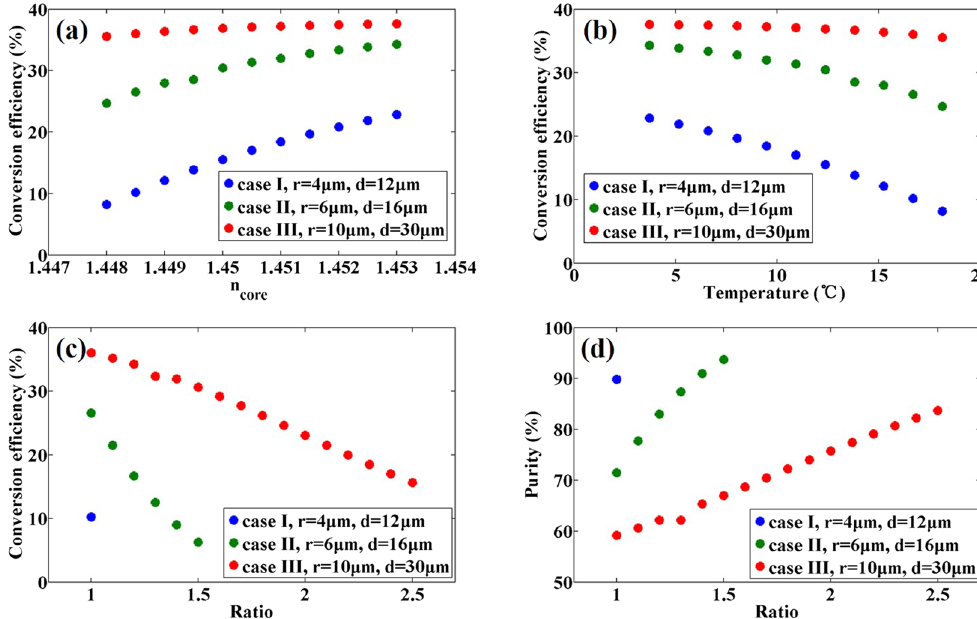
Figure 4. Dynamically controlled purity and CE. ( a ) CE versus n core , ( b ) CE versus temperature if cores are filled with formamide, ( c ) CE of OAM − 4 state and ( d ) purity of OAM 2 state versus stretching ratio under the same parameters as in case I (blue), case II (green) and case III